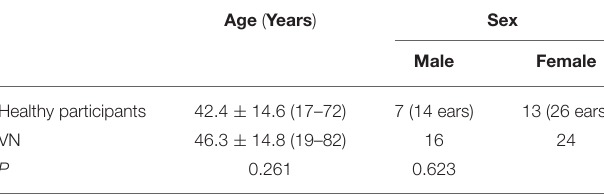
FIGURE 2 | HIMP and SHIMP graphs in left VN patient. The image above is bilateral HIMP and the image below is SHIMP of VN patient. In patients with VN, no catch-up saccades were found on the healthy side in the HIMP, while they were detected on the affected side. In contrast to the HIMP, large anti-compensatory saccades were observed on the healthy side in the SHIMP, while none were found on the affected side. TABLE 2 | HIMP and SHIMP parameters of the affected side in VN patients and TABLE 1 | Demographic features of the healthy participants and vestibular neuritis healthy (VN) groups.